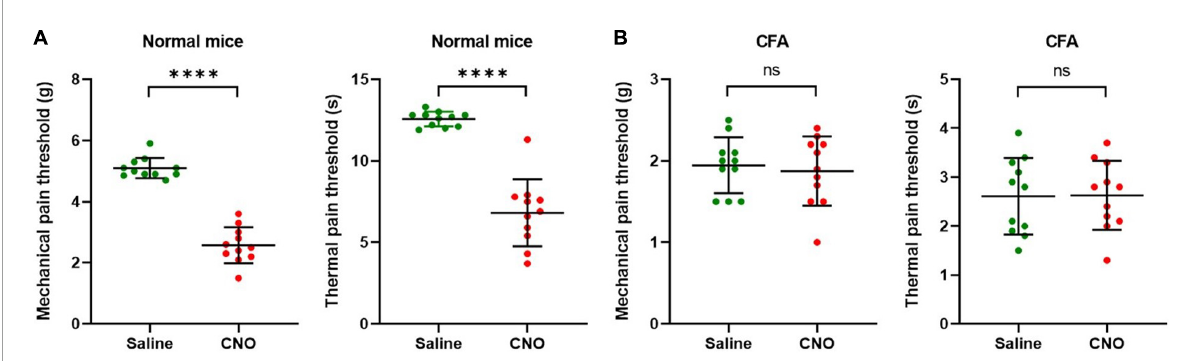
FIGURE5 Activation of shared neurons induced pain. (A) The mechanical pain thresholds and thermal pain thresholds of the ipsilateral hind paw plantar were decreased after CNO treatment in normal mice. n = 11, paired t -test. For mechanical pain thresholds, **** P < 0.0001. For thermal pain thresholds, **** P < 0.0001. (B) The mechanical pain thresholds and thermal pain thresholds of the ipsilateral hind paw plantar did not change significantly after CNO treatment in the CFA model. n = 11, paired t -test. For mechanical pain thresholds, P = 0.7334. For thermal pain thresholds, P =